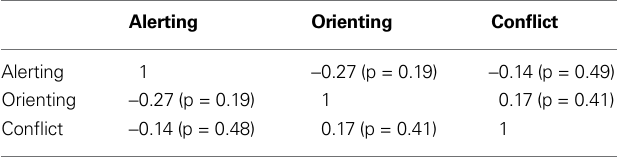
Table 1 | Attention component correlations.